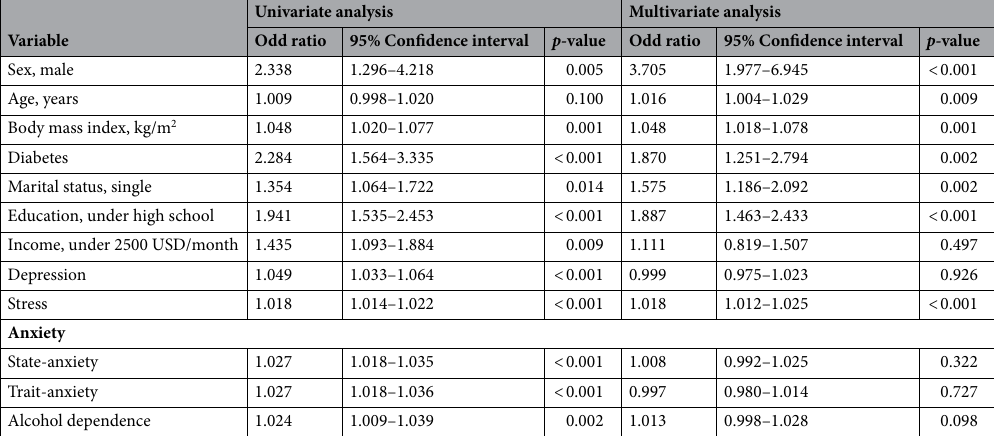
Table 4. Predictor of high nicotine